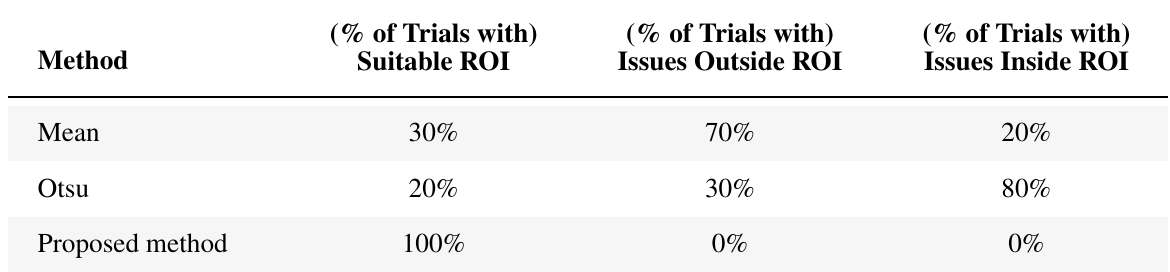
Table 1. Comparing different methods for automatically extracting regions of interest from ten arbitrarily selected thermograms. The resulting numbers are from experiments in Figure